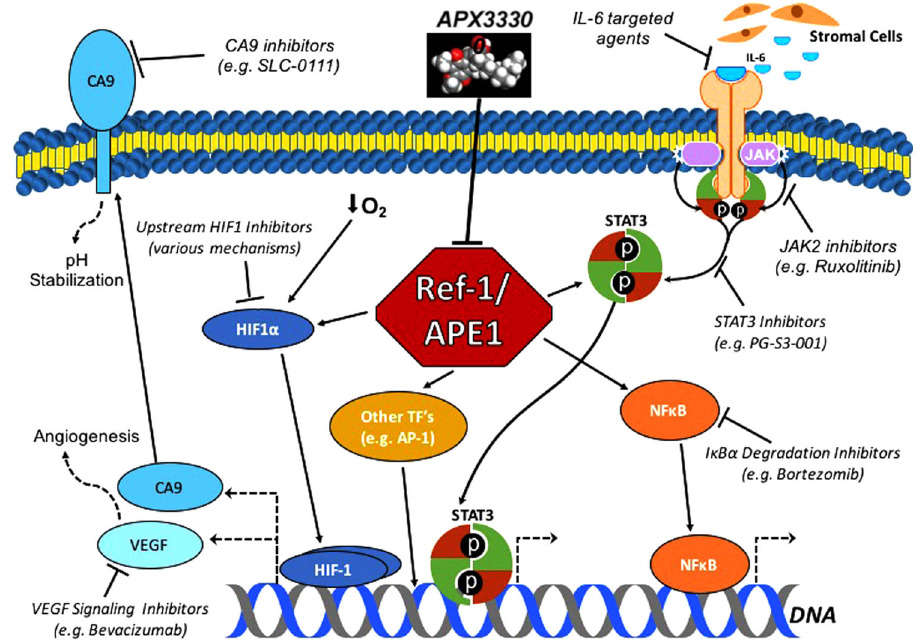
Fig. 2 Potential inhibitors of the Ref-1/APE1 signaling node and related pathways in tumor cells. Ref-1/APE1 redox signaling promotes the transactivation of transcription factors such as STAT3, HIF-1 α , and NF- κ B. Inhibiting Ref-1/APE1 with APX3330 decreases the expression of downstream genes, leading to tumor cell growth arrest and/or death. Additionally, other methods for inhibiting the signaling pathways affected by Ref-1/APE1, as well as the enzymes that are upregulated by these pathways, have been shown to enhance the cytotoxic and cytostatic effects of Ref-1/APE1